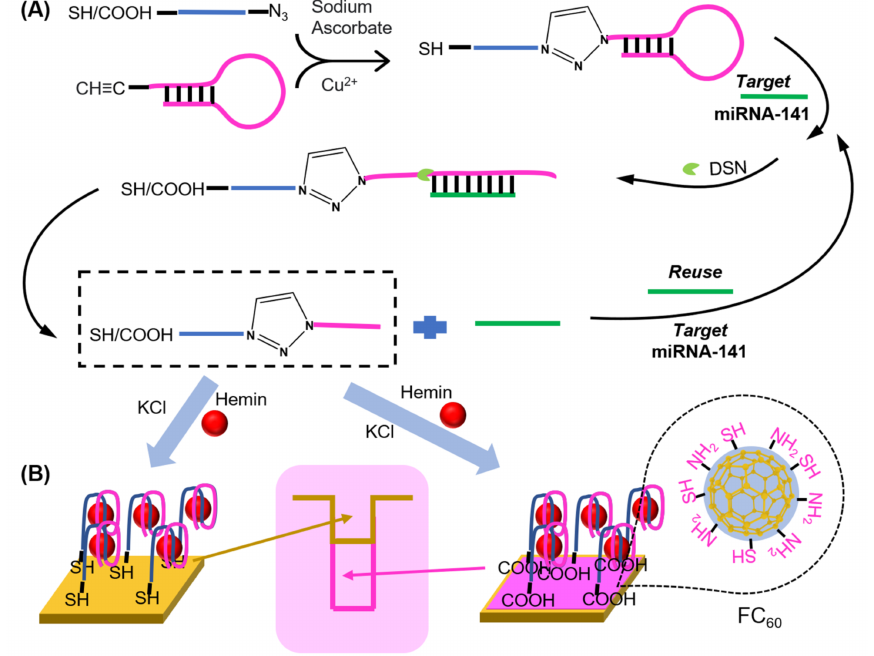
Figure 15. Schematic diagram of ( A ) EATR (enzyme-assisted target recycling) and ( B ) FC 60 dual- amplification strategy for an electrochemical biosensor: DSN, duplex-specific nuclease; and FC 60 , amino and thiol group multi-functionalized fullerene